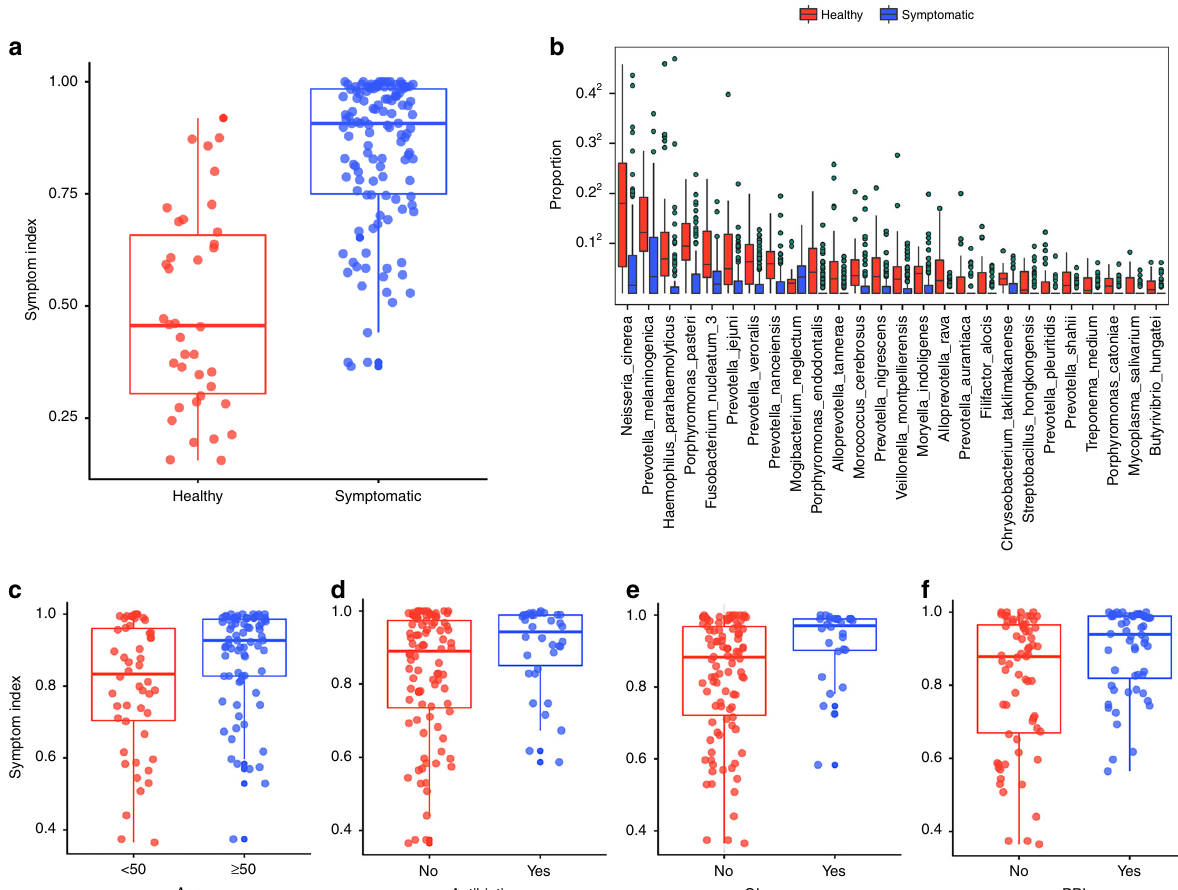
Fig. 2 Symptom index differentiates healthy controls from patients with GI symptoms. a Symptom index indicating the probability (0 – 1) of being classi fi ed in the symptomatic patient group determined using Random Forests classi fi cation based on the individuals ’ OTU pro fi les. b Tukey boxplots show differences in relative abundance of the 26 OTUs among symptomatic patients ( n = 126, blue) and healthy controls ( n = 38, red) that signi fi cantly contribute to the Random Forest classi fi cation performance based on Boruta feature selection (boxplots show the median with IQR and 1.5 IQR whiskers). The four factors contributing to the variance in the symptom index among healthy controls (red) and symptomatic patients (blue) are c age d history of antibiotic use within 3 weeks e history of GI surgery and f